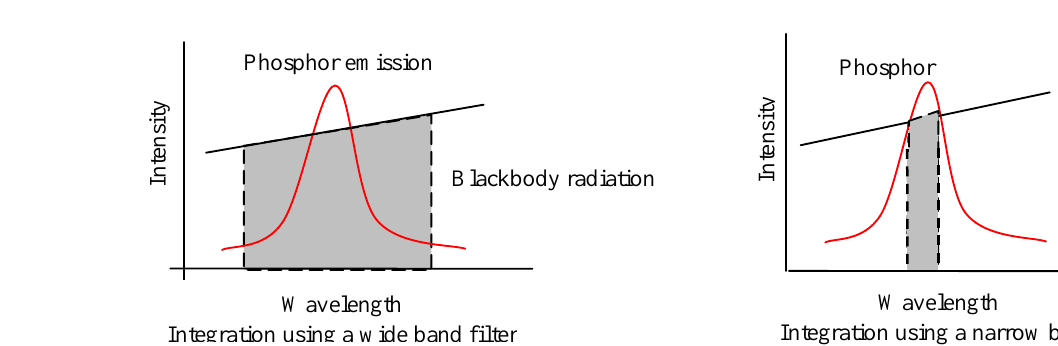
Figure 32. Figure to show the amount of background radiation (shaded area) collected using wide and narrow band